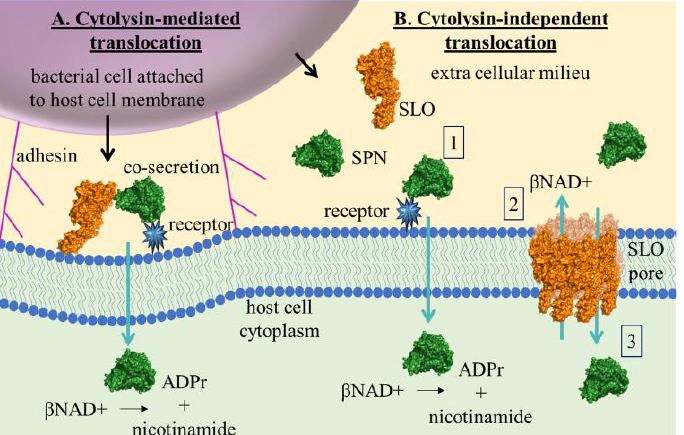
Figure 6. Models of SPN and SLO-mediated β NAD+ depletion. ( A ) Cytolysin-mediated translocation (CMT [8,29]). Co-secreted SPN (green structure, PDB 3pnt [30]) and SLO (orange structure, PDB 4hcs [31], orange) by GAS attached to host cell membrane. SPN binds to unknown carbohydrate receptor (blue star) to orient SLO for cytolysin-mediated translocation. ( B ) Cytolysin-independent translocation (this study). Possible mechanisms include: (1) SPN binds unknown carbohydrate receptor for SLO-independent translocation. SLO augments β NAD+ depletion by (2) forming pores that enable diffusion of β NAD+ out of the cell and/or (3) by facilitating diffusion of SPN into the cell.